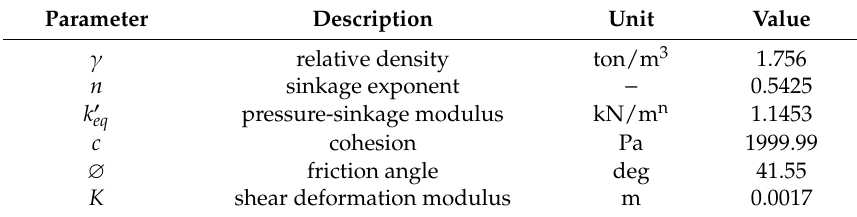
Figure 3. Experimental results of pressure-sinkage test for identifying the terrain characteristics associated with normal stress on the lunar simulant. Table 1. Predicted lunar simulant